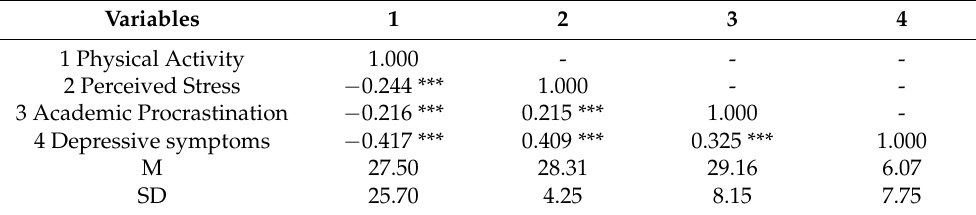
Table 2. Descriptive statistics and correlation analysis results ( n =